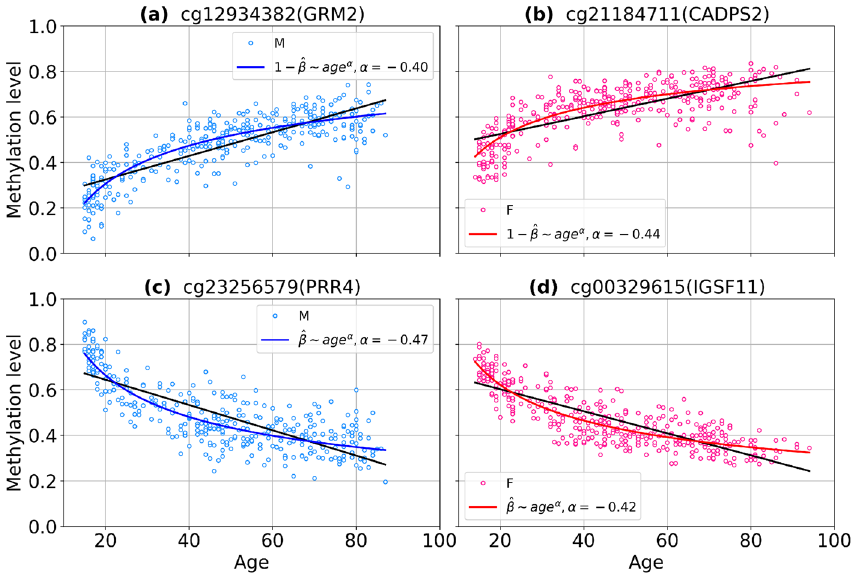
Figure 13. Demonstration of the difference between a power law fits and a linear ones. Scatter plots of power law CpGs identified in GSE87571 dataset. Curves represent a power law fit for males (blue curves) and females (red curves). Black lines represent a linear regression fits. ( a , c ) on the left panel show methylation level of males, ( b , d ) on the right panel show methylation level of